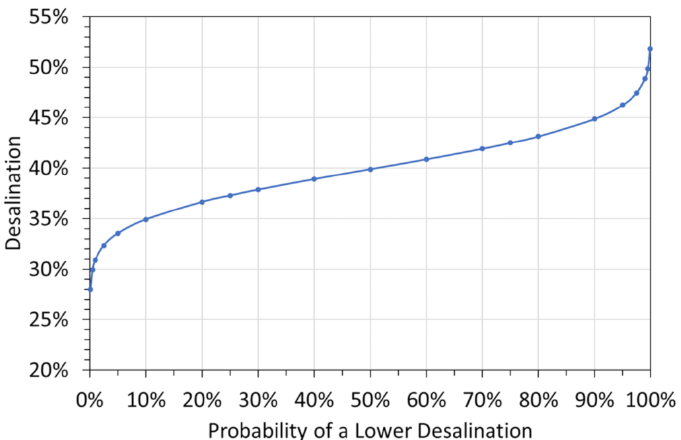
Figure 5. Expected desalination distribution associated with a 650 train reactor, processing 550 m 3 d − 1 (200,750 m 3 a − 1 ). 1000 iteration Monte Carlo Analysis; assumptions: 20 h batch operating time;